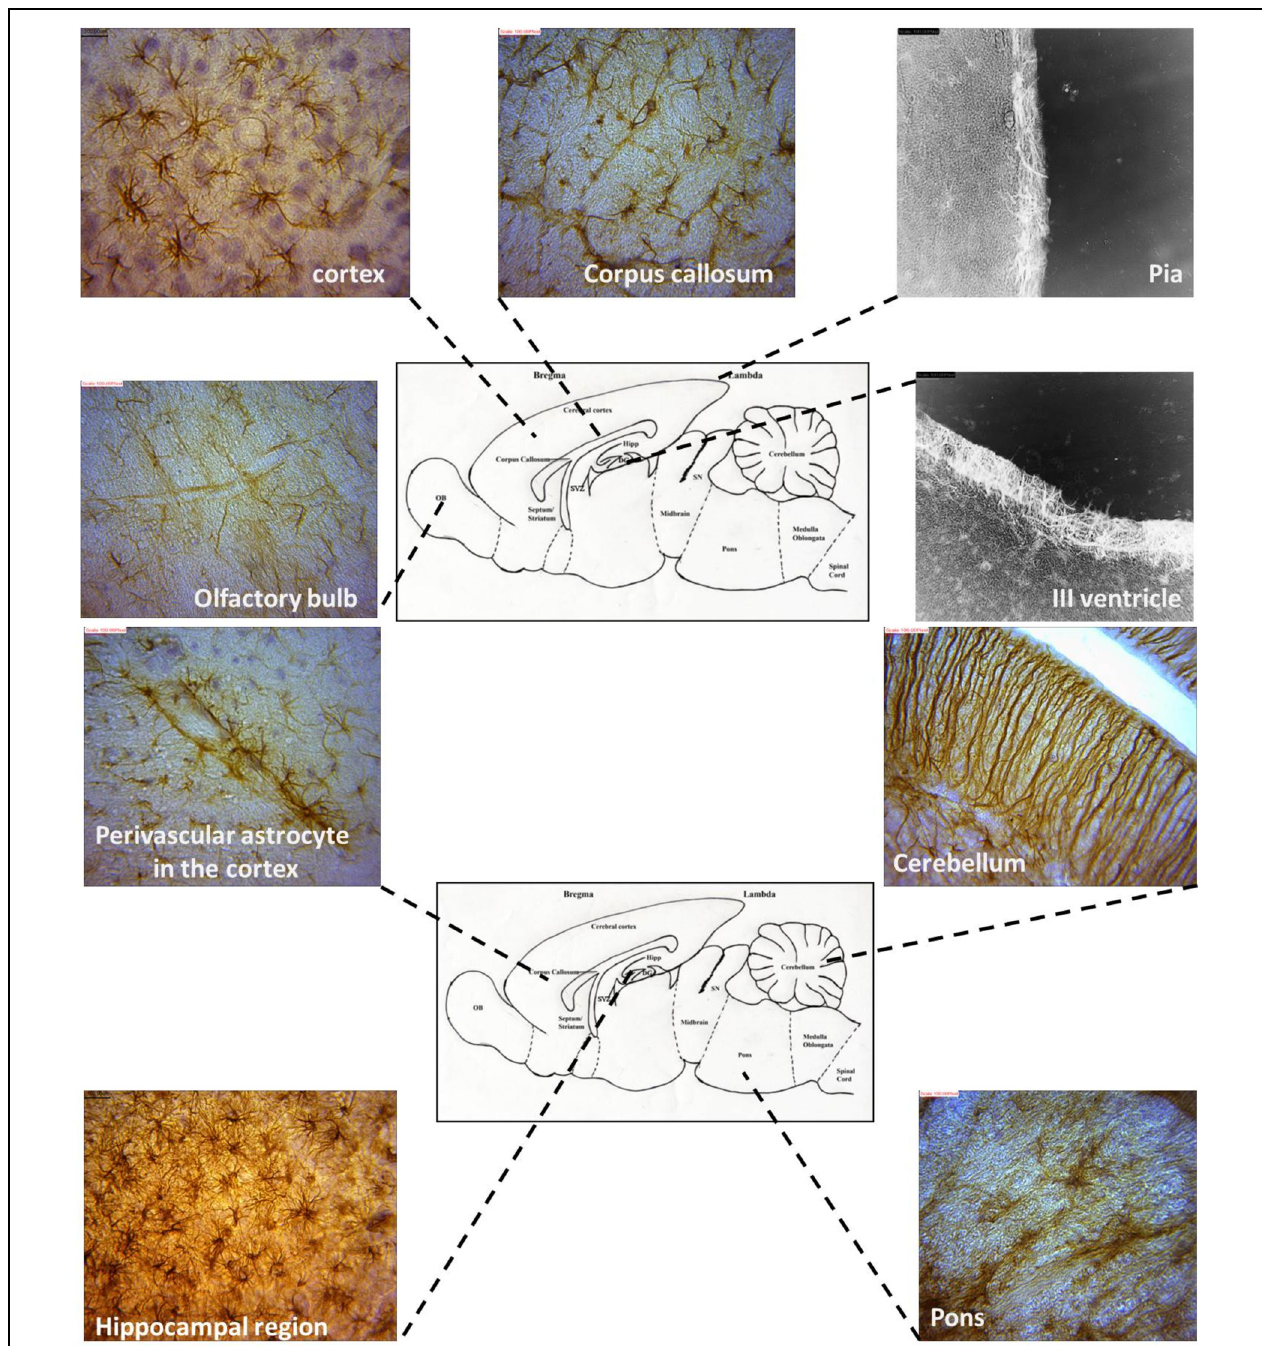
FIGURE 6 | Representative astrocyte morphologies from selected regions of the AGR brain (Images were obtained from sagittal sections and immunolabeled with GFAP).